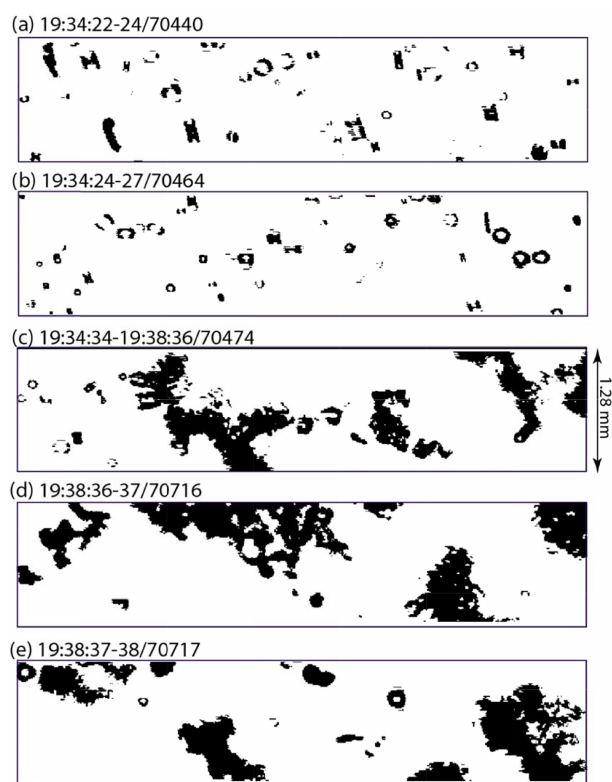
Figure A5. 2D-S images of ice for selected periods during layer sampling associated with the right column of Fig. 7. Temperatures were ∼ − 10 ◦ C, at an altitude of 6.75km. Annuluses are ice imaged out of